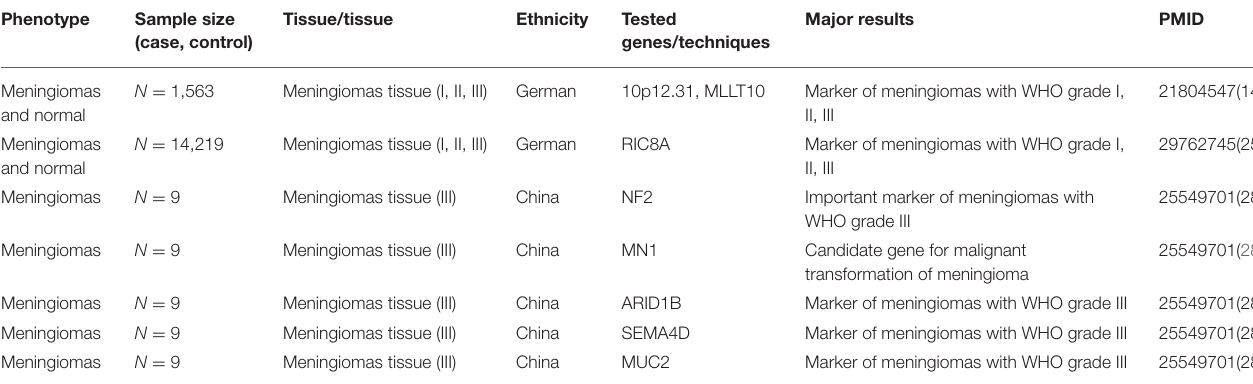
TABLE 1 | Genomics research associated with